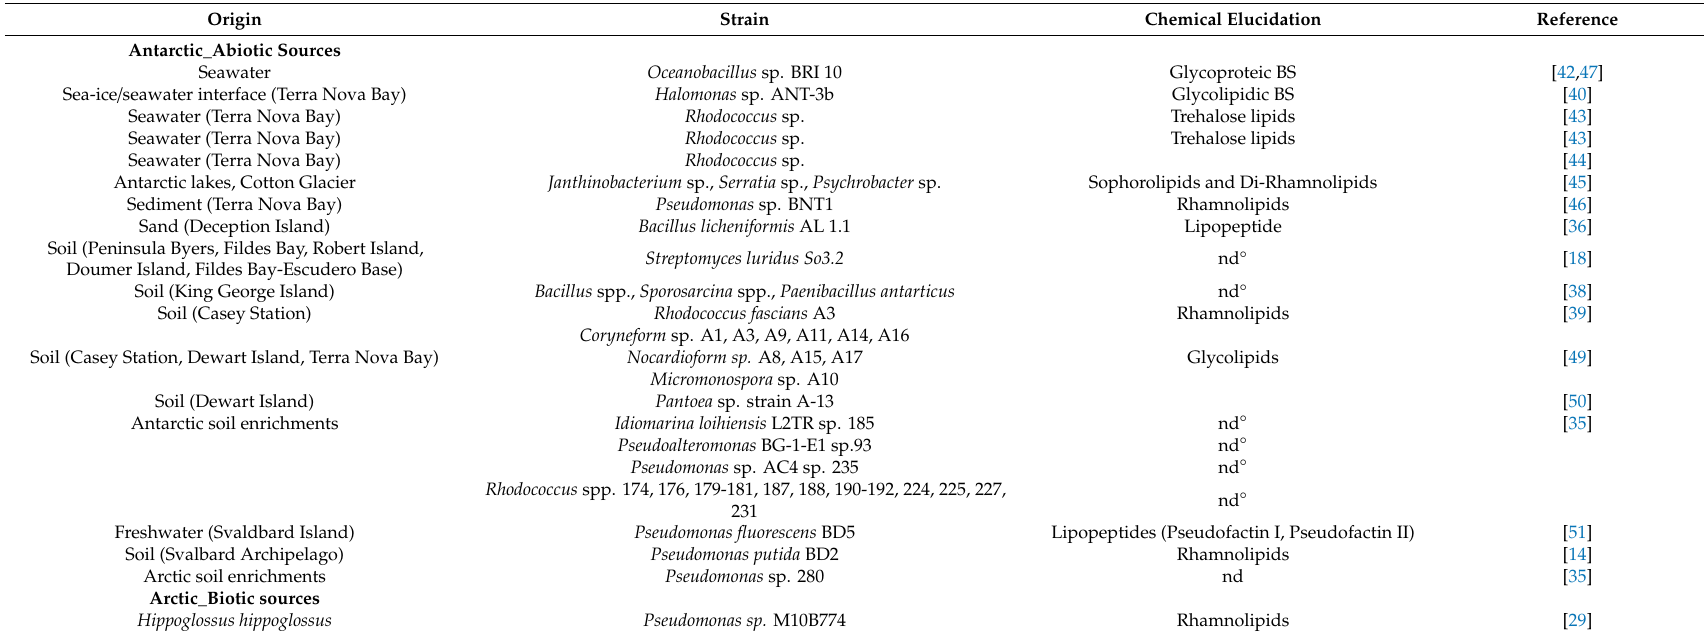
Table 1. List of cold-adapted biosurfactant (BS) bacterial producers considered for the review